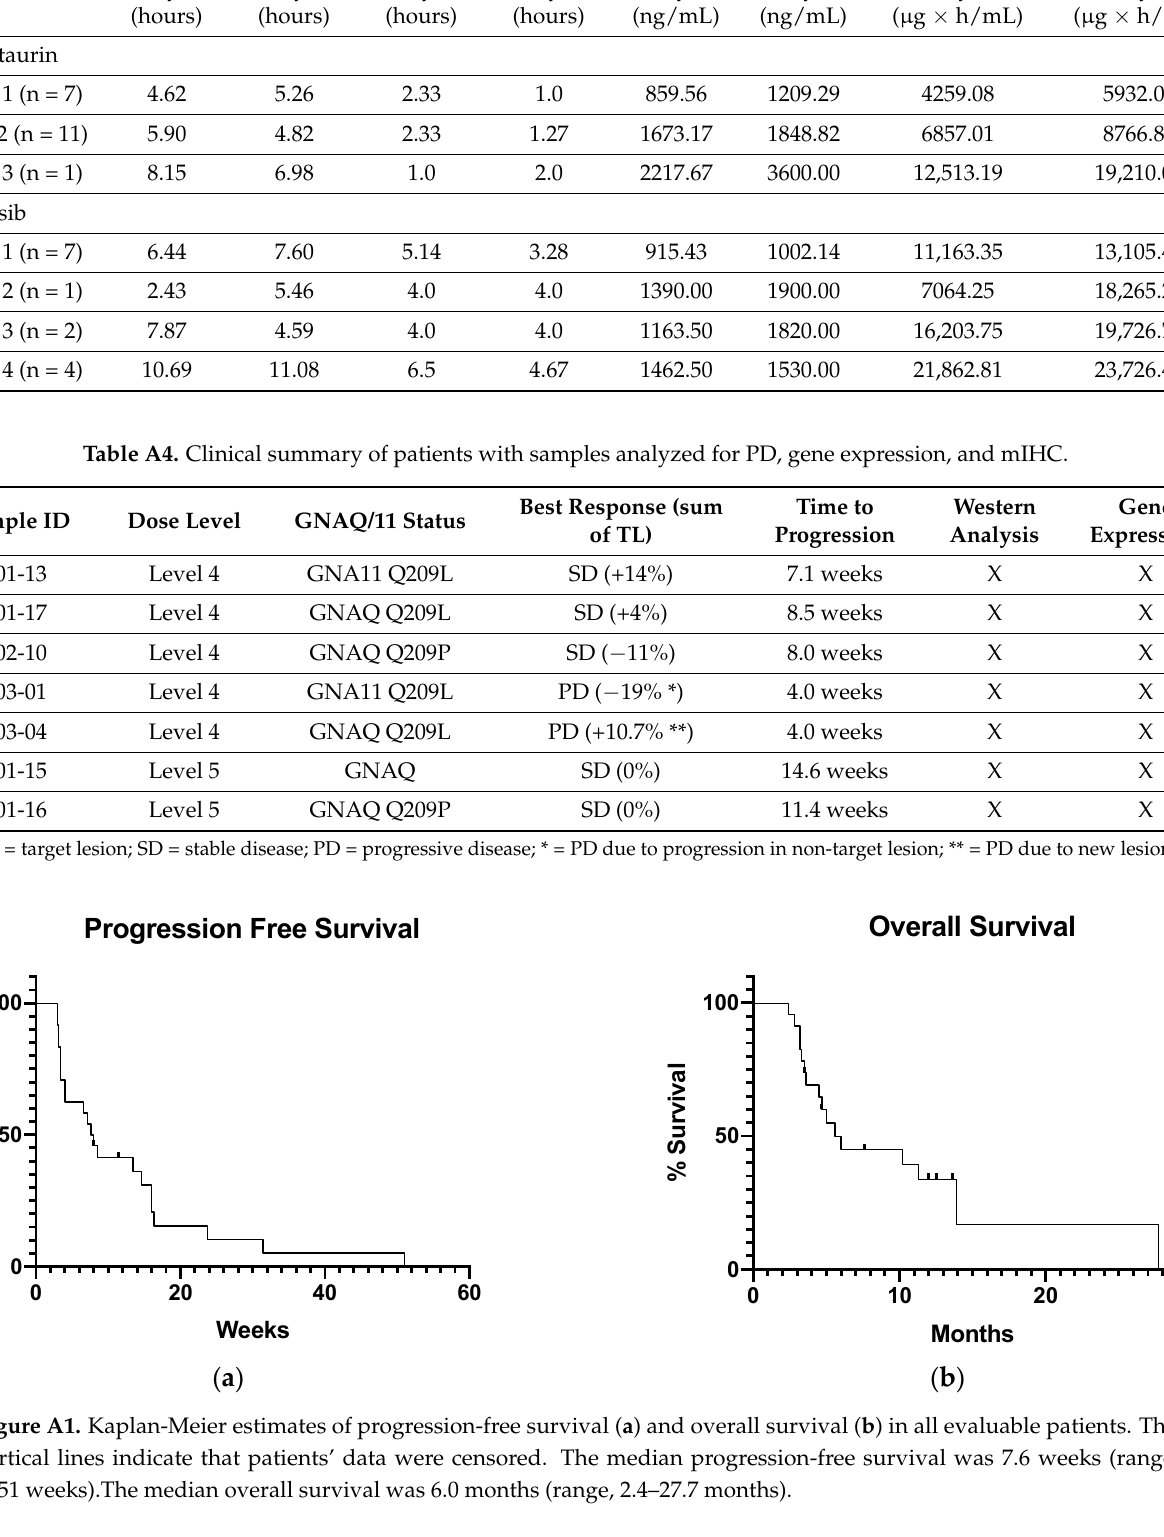
Figure A2. Supplemental Western blot analyses for potential markers of cell proliferation, apoptosis, and metabolic activ- ity. Paired tumor biopsies were assessed by western blot for Cyclin E1, D1, A2, Bcl-2, and GLUT4. GAPDH was used as a loading control. References 1.